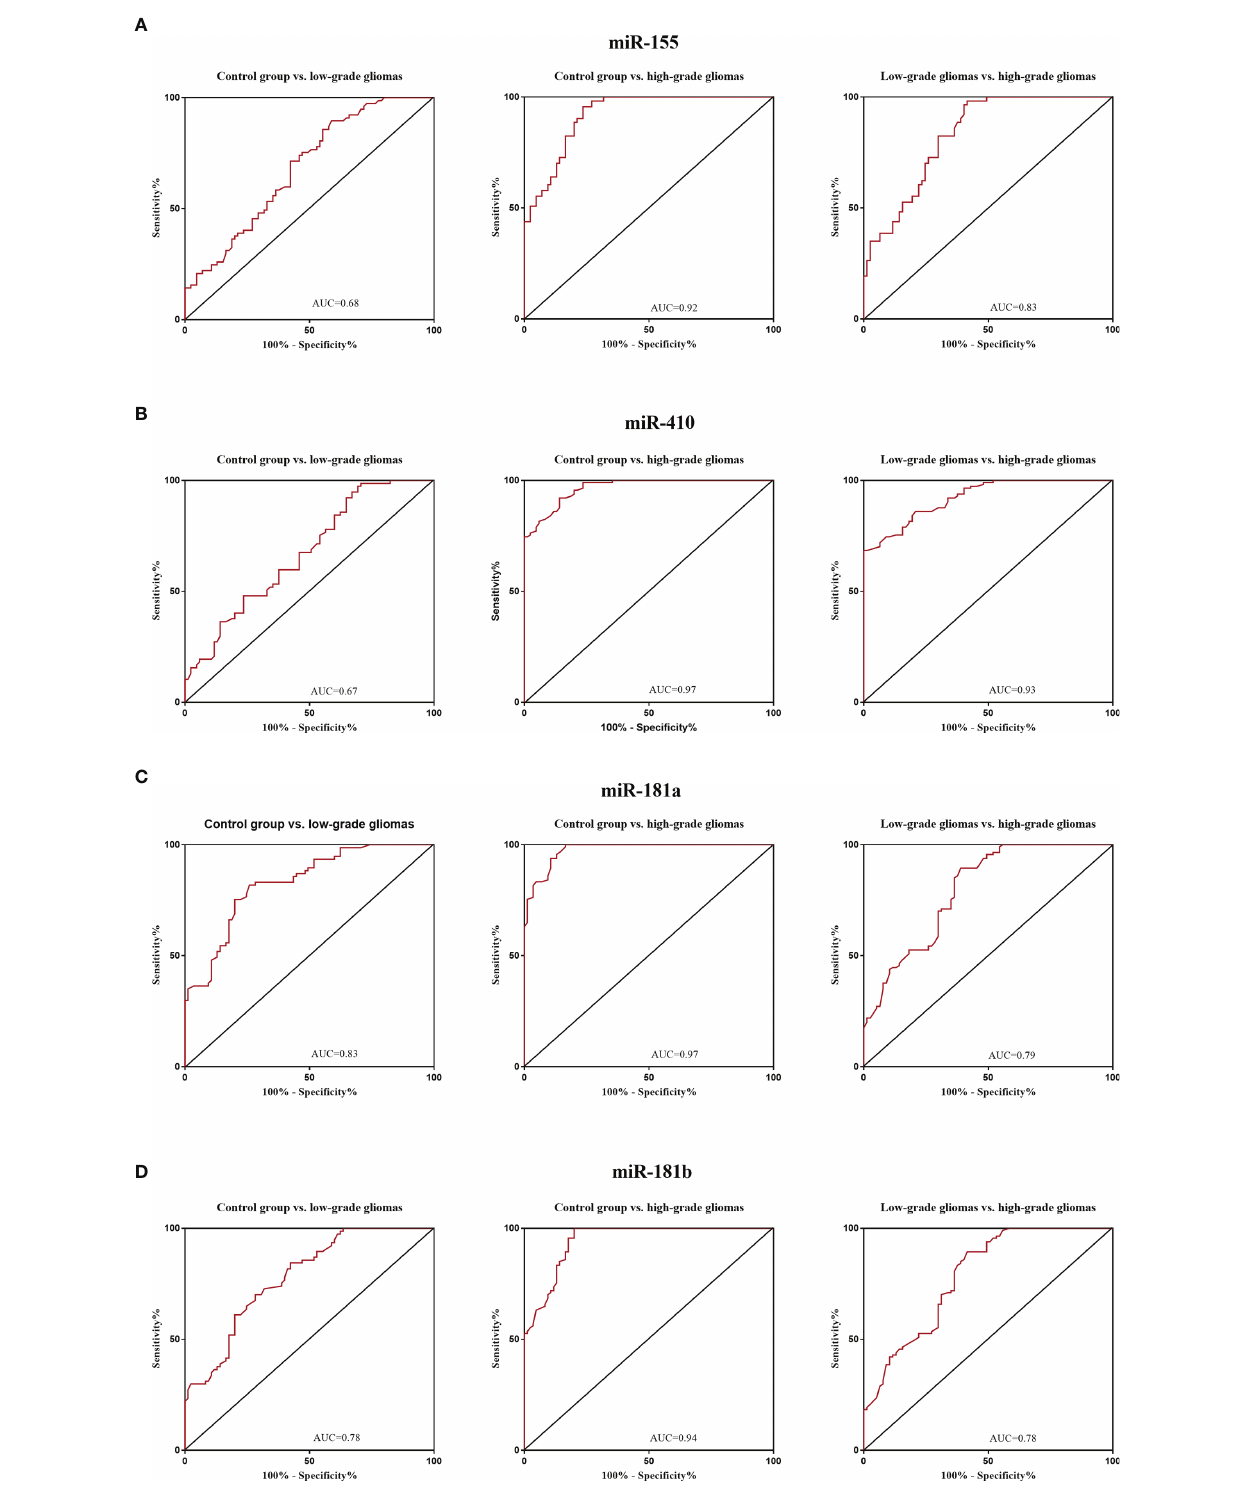
FIGURE 7 | Receiver Operating Characteristic (ROC) curves for circulating miR-181a/b, miR-410 and miR-155 for glioma patients before surgery (A – D) . In panel (A, B) of the fi gure the area under the curves (AUCs) for circulating miR-155 and miR-410 were 0.68, 0.92, 0.83, 0.67, 0.97, 0.93 and in panel (C, D) for circulating miR-155 and miR-410 were 0.83, 0.97, 0.79, 0.78, 0.94, 0.78